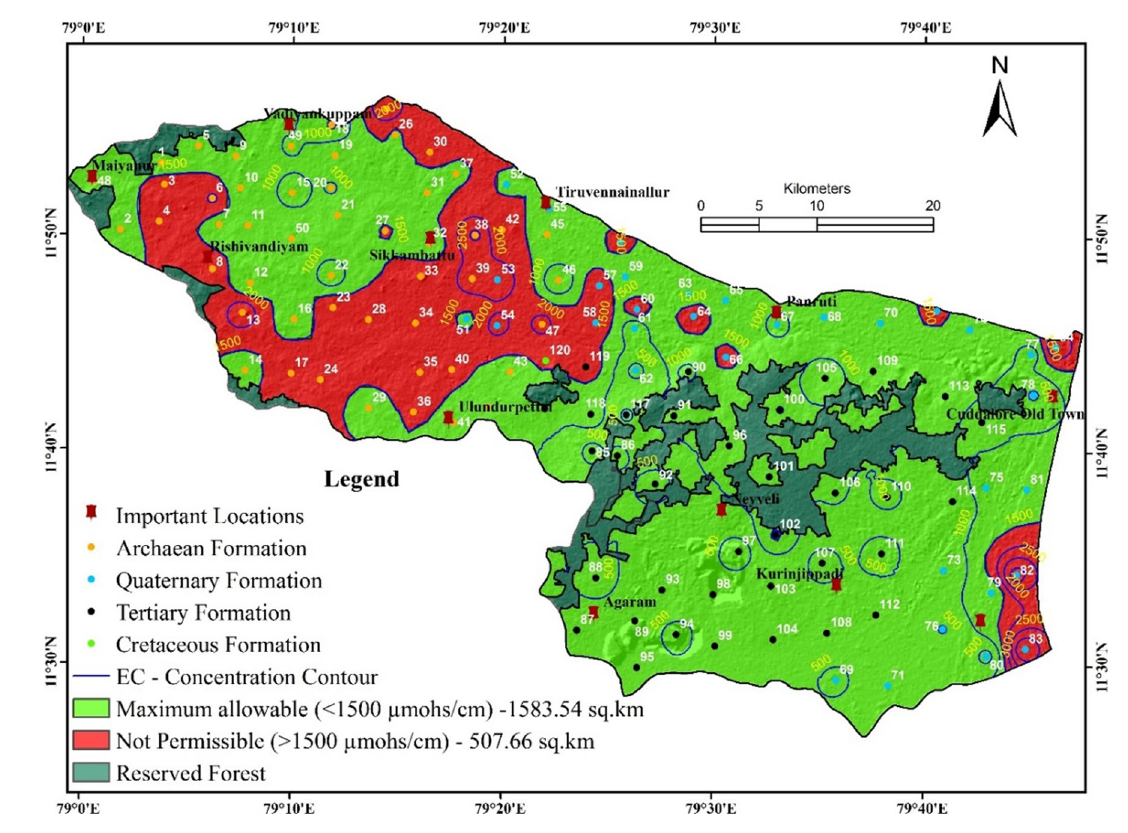
Fig. 4 Groundwater quality